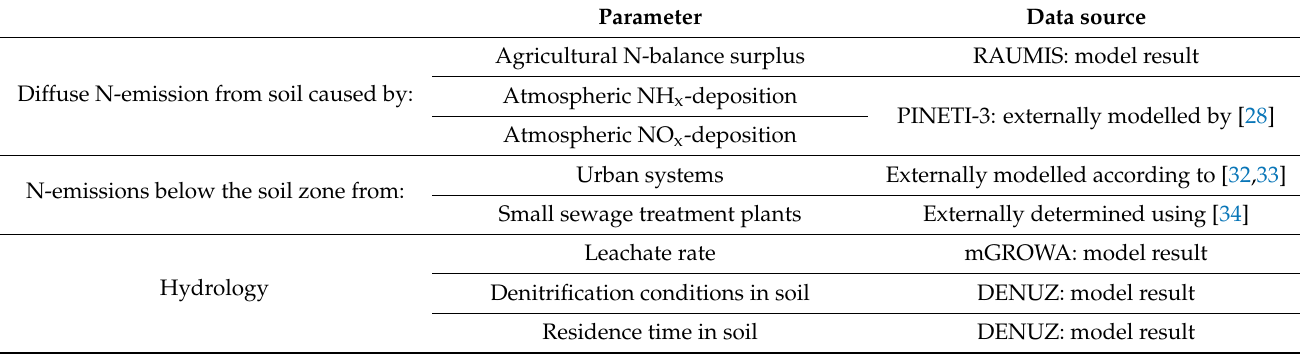
Table 1. Input parameters for determining nitrate concentrations in the